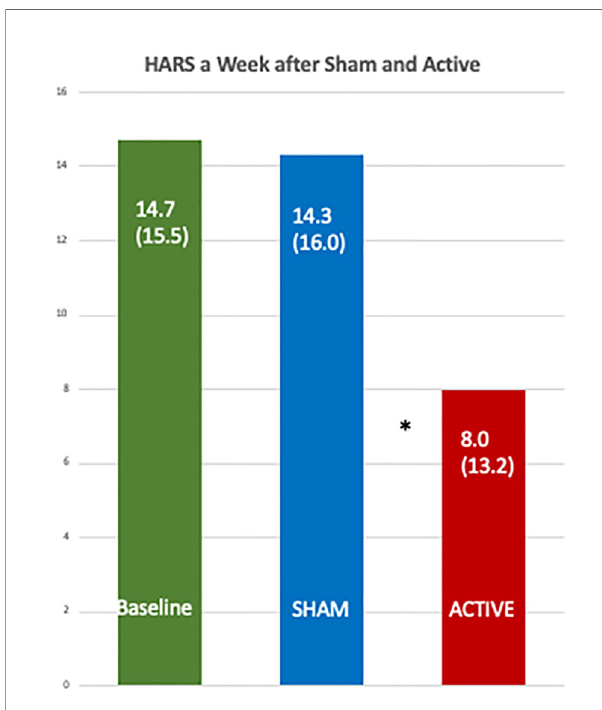
FIGURE 5 | Comparison of the baseline Hamilton Anxiety Rating Scales with those one week after the active and the sham treatments. The differences between the scores after the active [8.0 (SD 13.2)] and sham treatments [14.3 (SD 16.0)] were signi fi cant by a one-sided, Wilcoxon Test, *p = 0.012.